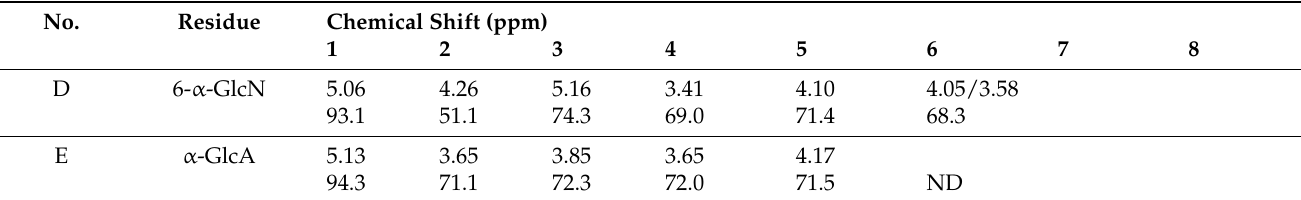
Table 1. NMR assignments of glycosyl residues identified in the Ko–lipid A of G. bethesdensis . For NMR spectra, refer to Figure 3.